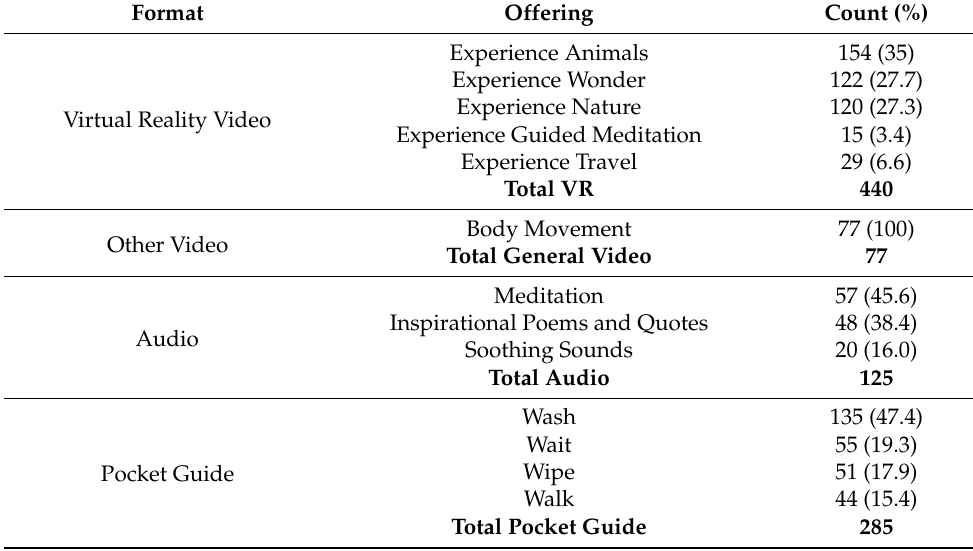
Table 10. Quick Response Video, Audio, Pocket Guide